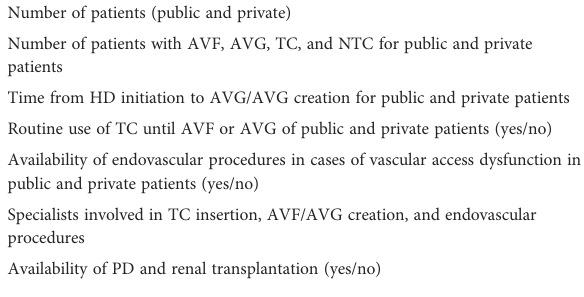
TABLE 1 Survey questions about vascular access pro fi le and care accessibility. Number of patients (public and private) Number of patients with AVF, AVG, TC, and NTC for public and private patients